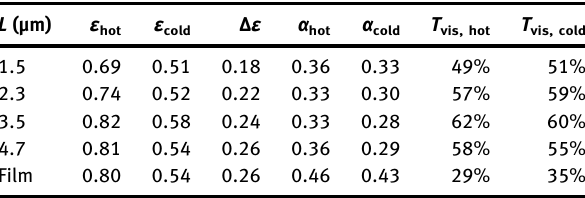
Table  : Summary of calculated IR emissivity, solar absorption and visual transmittance at hot and cold status using measured exper- imental spectra (Figure 